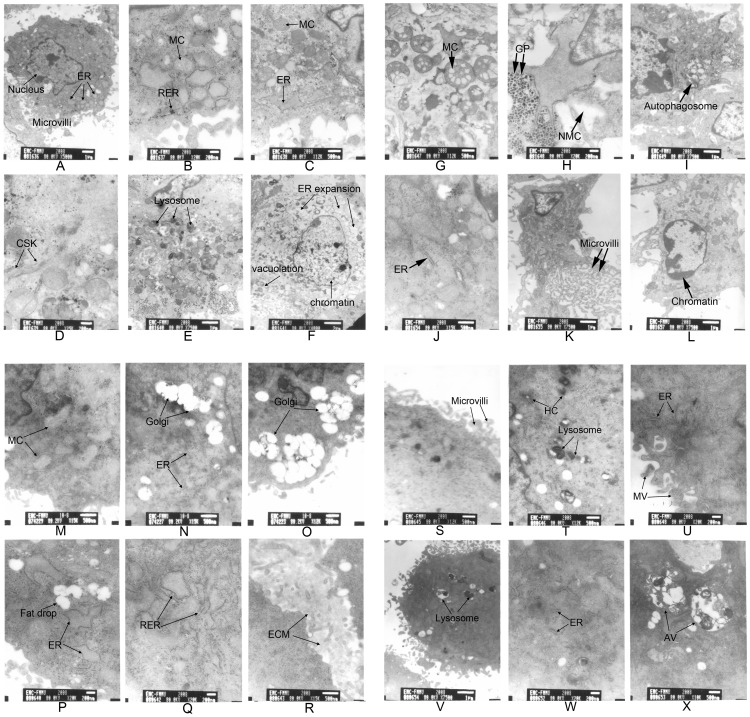
Detection of the effects of LG-HMF on MC3T3-E1 (A–L) and MG-63 (M–X) morphology by transmission electron microscopy (TEM).After MG-63 and MC3T3-E1 cells were cultured in the bore of LG-HMF (μ-g, 1-g, and 2-g) at 37°C for 24 h, the osteoblasts were fixed with 2.5% glutaraldehyde, then dehydrated by gradient acetone and embedded. Ultra-thin sections were contrasted according to Reynolds and examined in a JEOL analytical transmission electron microscope. MC: mitochondria, ER: endoplasmic reticulum, GP: glycogen particles, NMC: nucleus membrane cavity, CSK: cytoskeleton, HC: heterochromatin, MV: microvilli, RER: rough endoplasmic reticulum, ECM: extracellular matrix, AV: autophagic vacuoles. N: A–L: MC3T3-E1cells, M–X: MG-63 cells. A–C and M–O: control, D–F and P–R: μ-g, G–I and S–U: 1-g, J–L and V–X: 2-g.